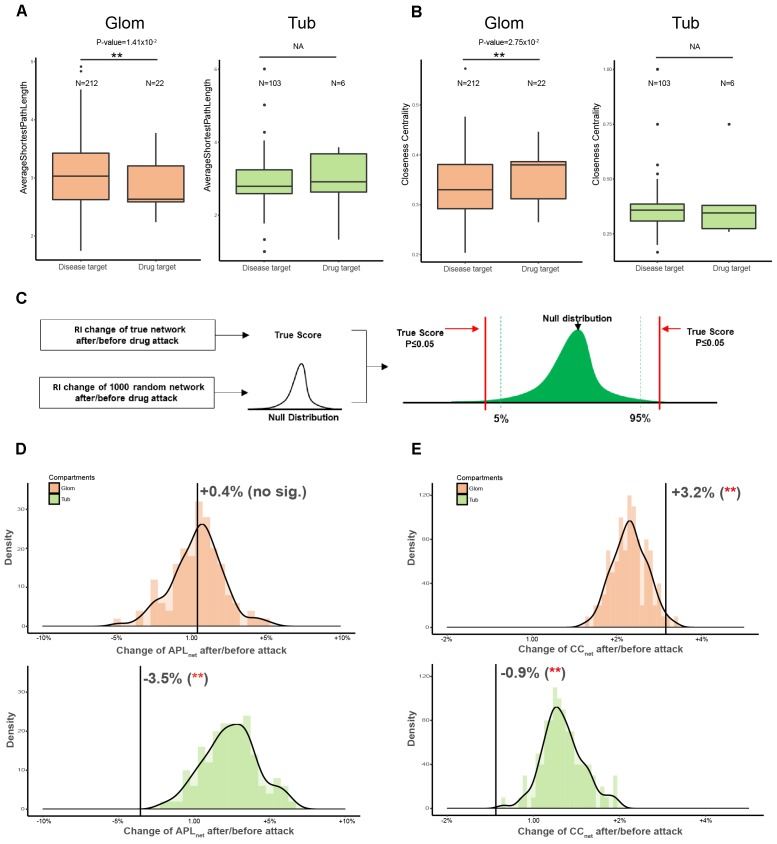
Comparison of topological features of drug-attacked node in tubulointerstitial and glomerular network. (A,B) Boxplot of APLnode
(A) and CCnode
(B) of drug-attacked nodes and other nodes in tubulointerstitial and glomerular network. ∗∗p-value < 0.05. (C) Schematic diagram of Permutation test. Network topological features were used as robustness indicators (RI) of networks. Null distribution of RI of 1000 random network was generated to maintain the same edge number of the true network and randomize interactions between nodes. Comparing with the null distribution, statistical significance of RI of true network can be calculated. (D,E) Robustness (APLnet for D, CCnet for E) of glomerular and tubulointerstitial network versus random network (green distribution for tubules and orange distribution for glomeruli). X-axis is the percentage change of robustness indicators before/after attack. ∗∗p-value < 0.05.